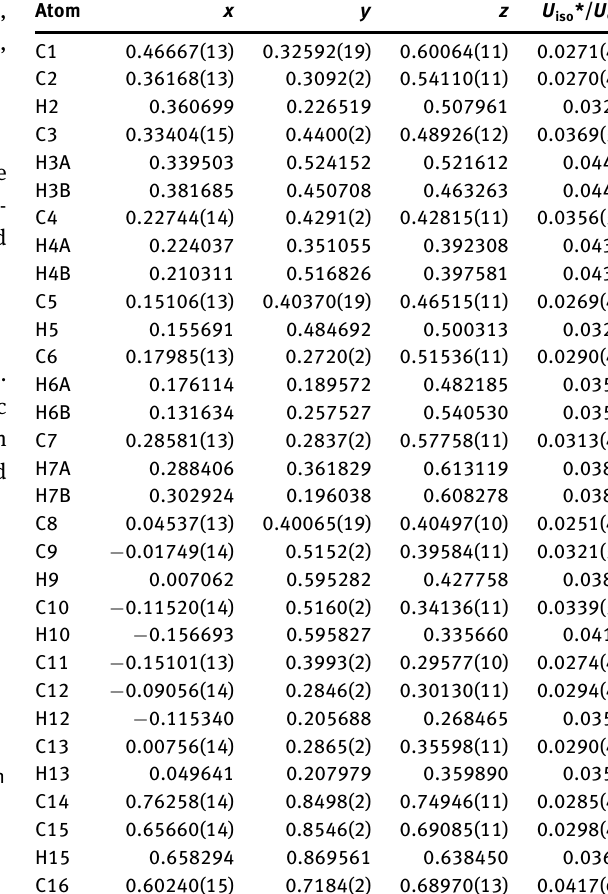
Table 2: Fractional atomic coordinates and isotropic or equivalent isotropic displacement parameters (Å 2